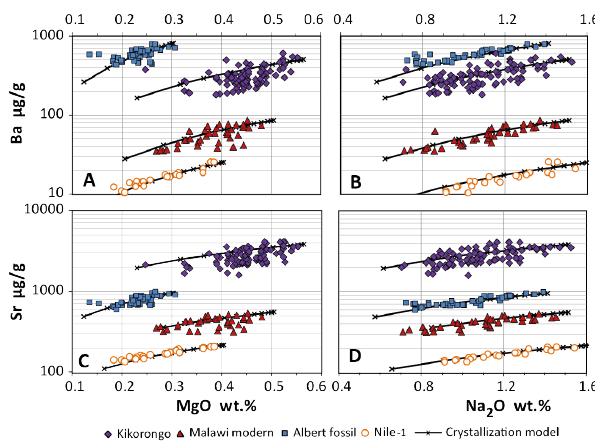
Fig. 4. Variation of MgO, Na 2 O, Sr and Ba in modern and fossil enamel from hippopotamid teeth. Note the large variation of Ba and Sr concentrations relative to MgO and Na 2 O. The coherent varia- tion of all elements regardless of age, element concentrations and profile location implies that the concentrations are controlled by a common process. Black lines represent model calculation assuming fractional crystallization of apatite from enamel fluid. For details see Sect. 4.1.2 and Table 2.